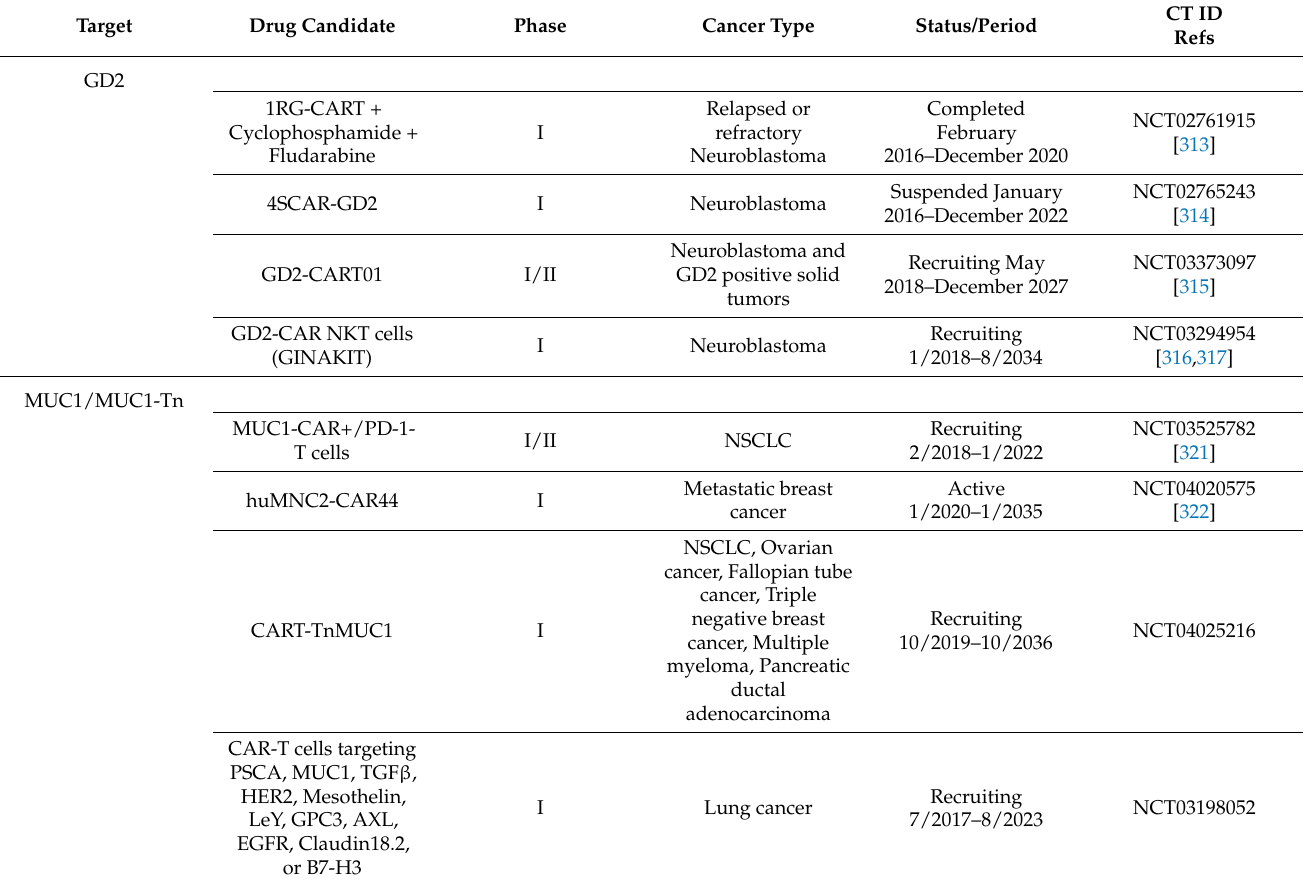
Table 4. Selected clinical trials of CAR-T cells targeting tumor